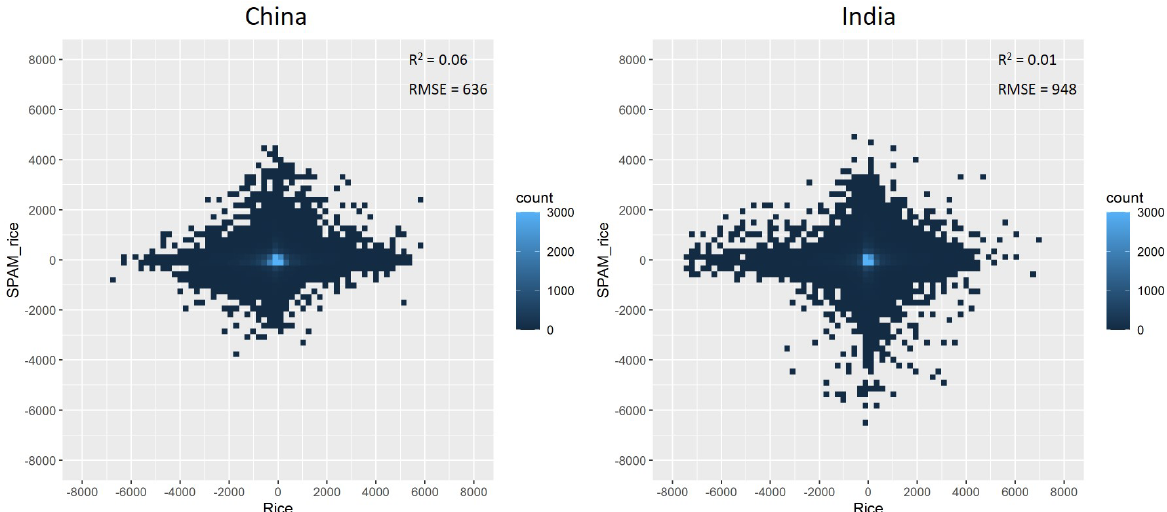
Figure 15. Comparison between SPAM rice area change and Zhang et al. (2017) paddy rice change (unit: